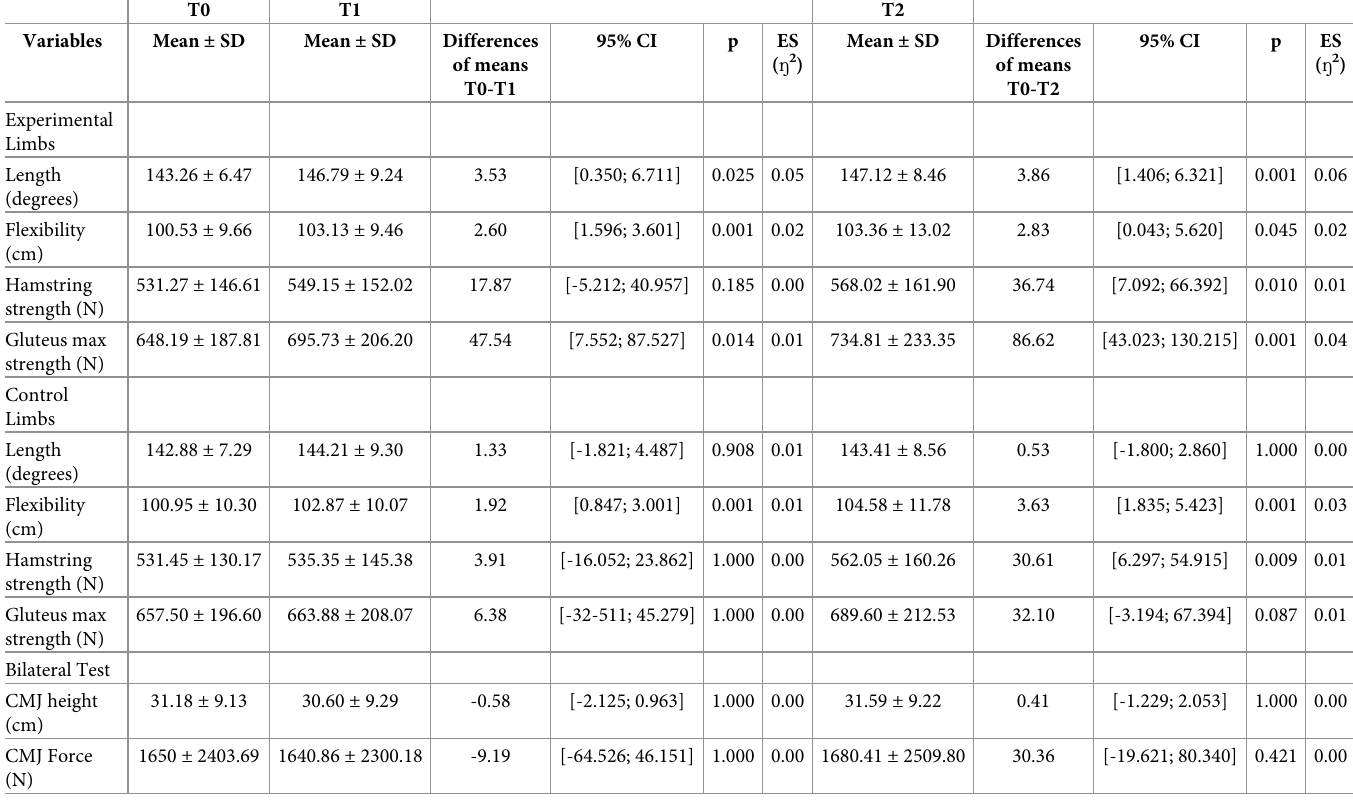
Table 2. Intra-group